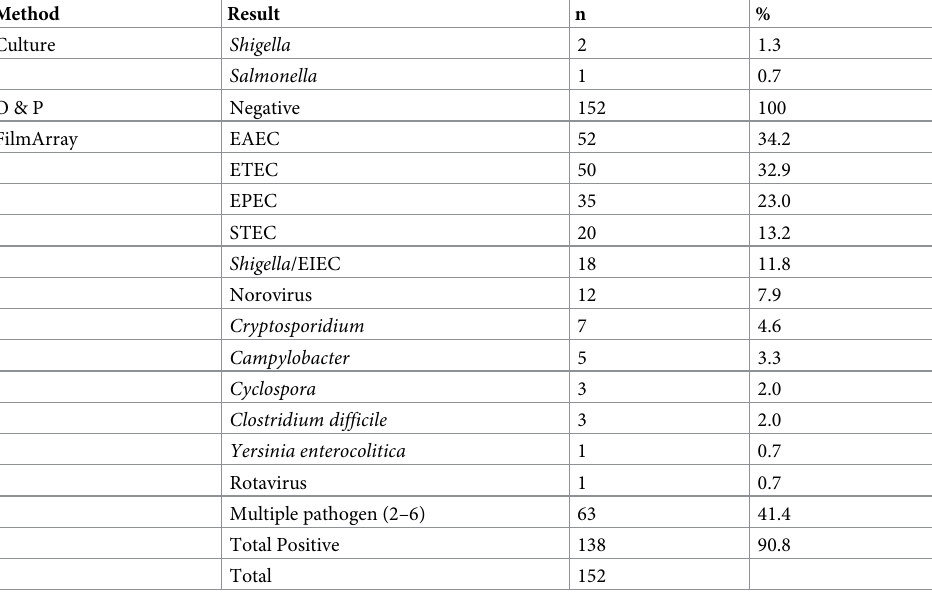
Table 4. Study 1 Laboratory results. O & P indicates ova and parasites.